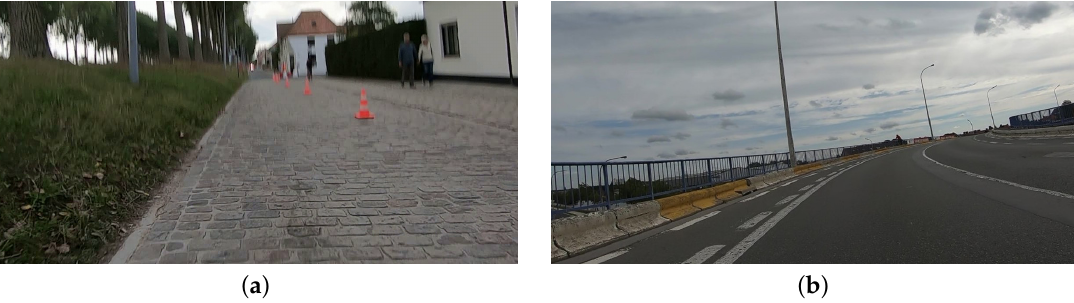
Figure 6. Examples of situations where the road surface is not flat: ( a ) cobbled road; ( b ) bridge